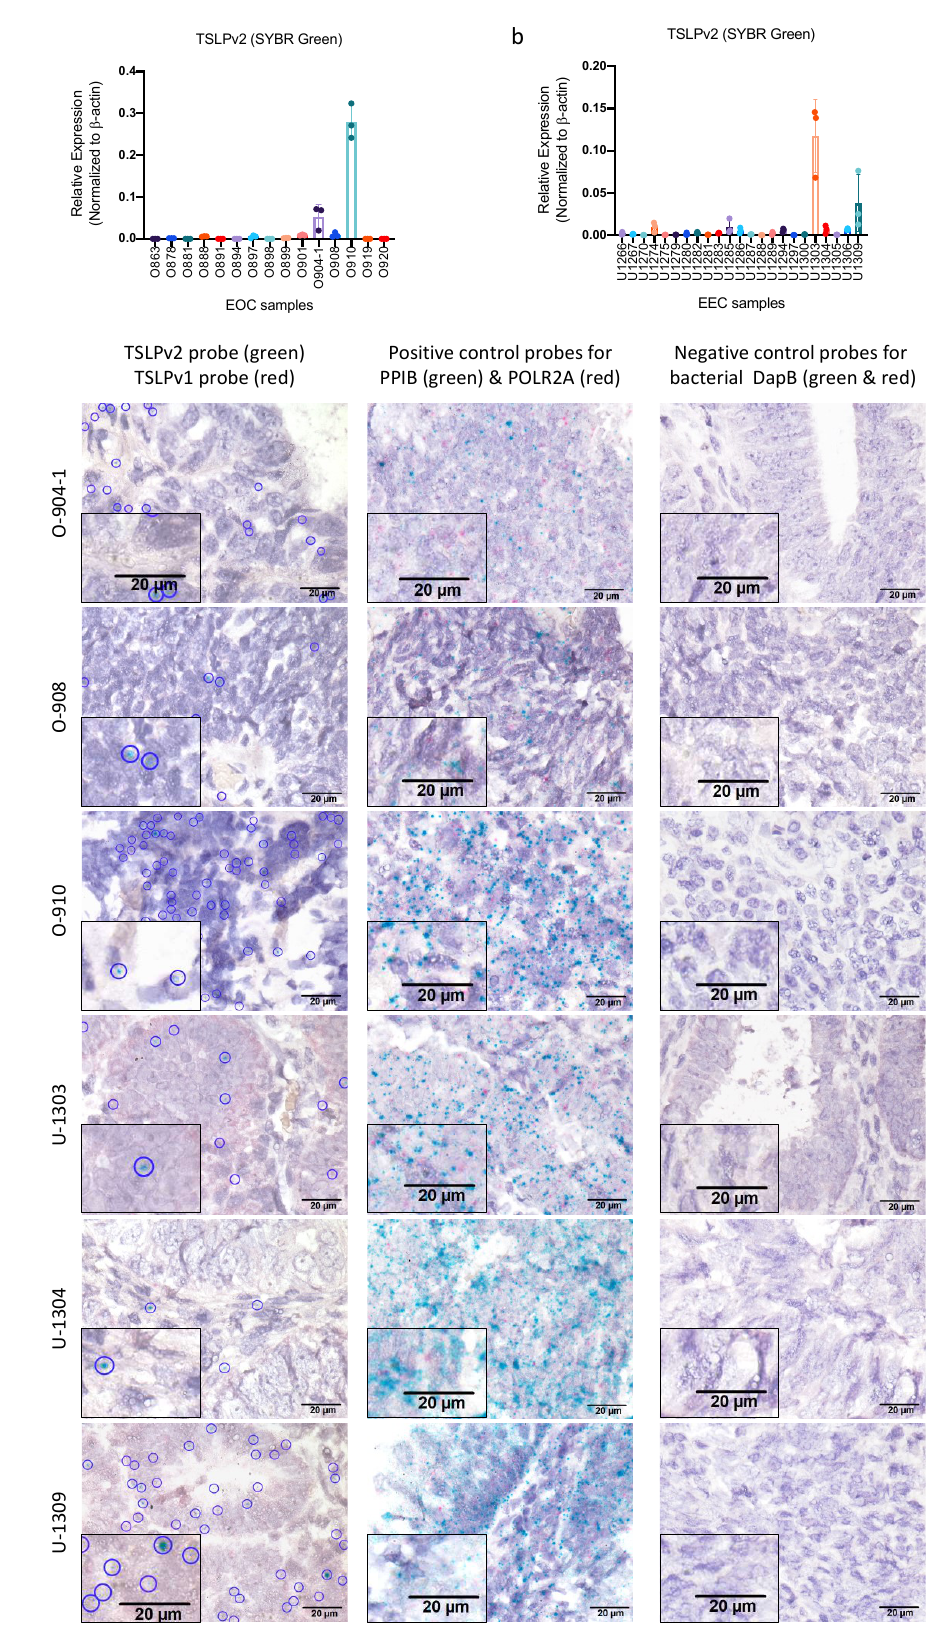
Figure 2. sfTSLP was expressed in human epithelial ovarian cancer and endometrioid endometrial cancer. ( a ) mRNA expression of sfTSLP in 15 tumour tissues of human epithelial ovarian cancer (EOC) was examined by qRT-PCR